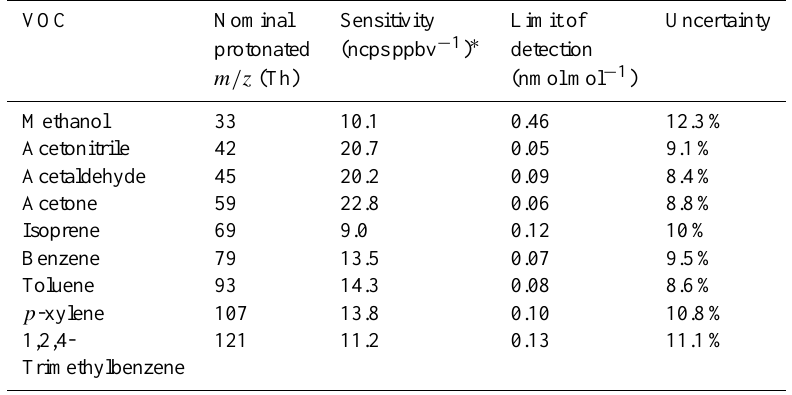
Table 1. Compound-specific VOC m/z assignments, sensitivity, detection limit and uncertainty. The limit of detection is defined as 2 σ of the measured normalized signal while measuring zero air divided by the